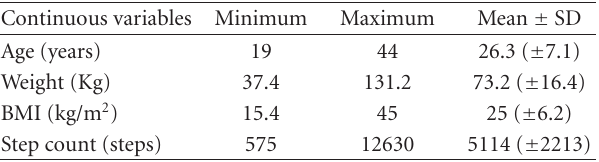
Table 3: Outcome measures scores ( n =